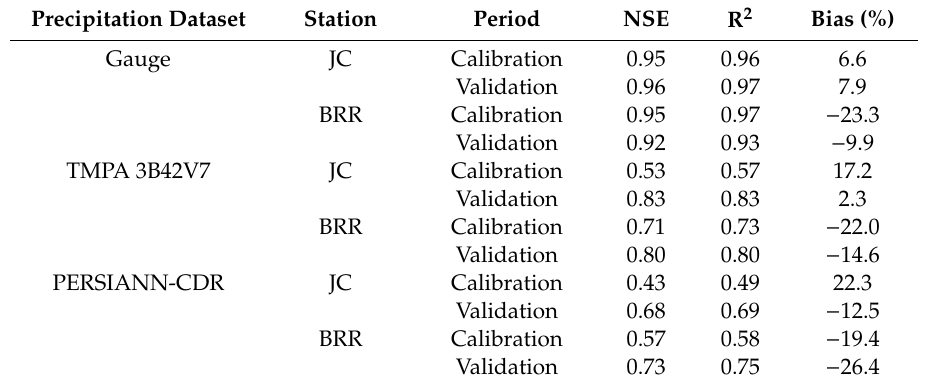
Table 3. Statistical indices for streamflow simulation at JC and BRR stations using three precipitation inputs.